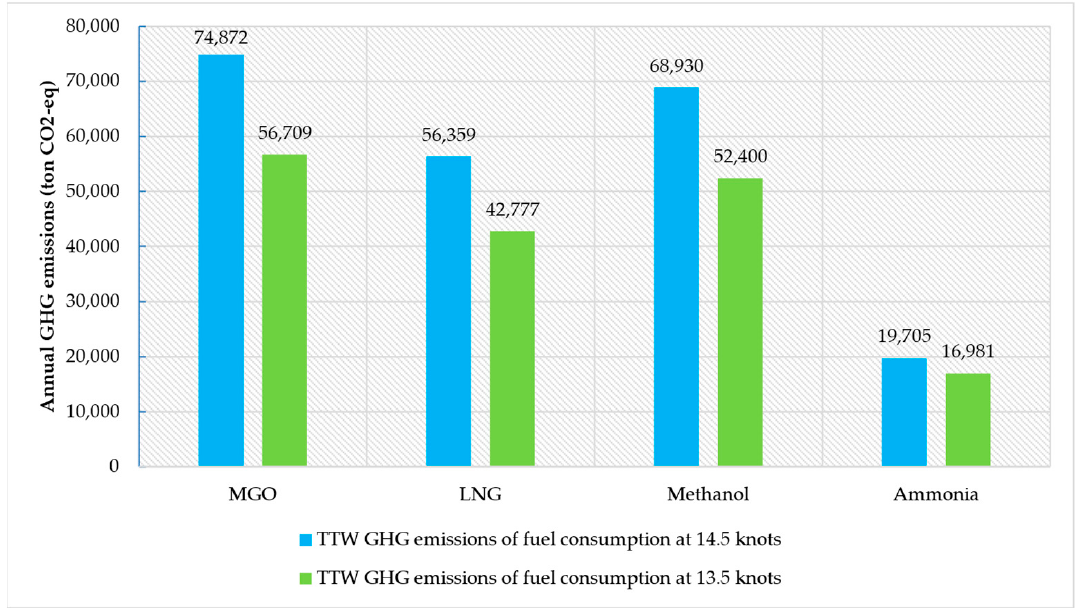
Figure 6. Annual TTW GHG emissions based on annual fuel consumption.